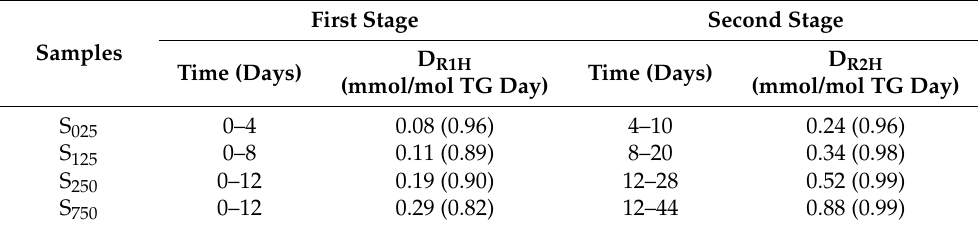
Table 2. Degradation rates (D R1H and D R2H ), expressed in mmol mol − 1 TG day − 1 , of HTy-Ac, in the two linear stages of its degradation path, depicted in Figure 3, in each one of the samples, S 025 , S 125 , S 250 and S 750 , over the storage time at 70 °C. The correlation coefficients of these lines are given in brackets.